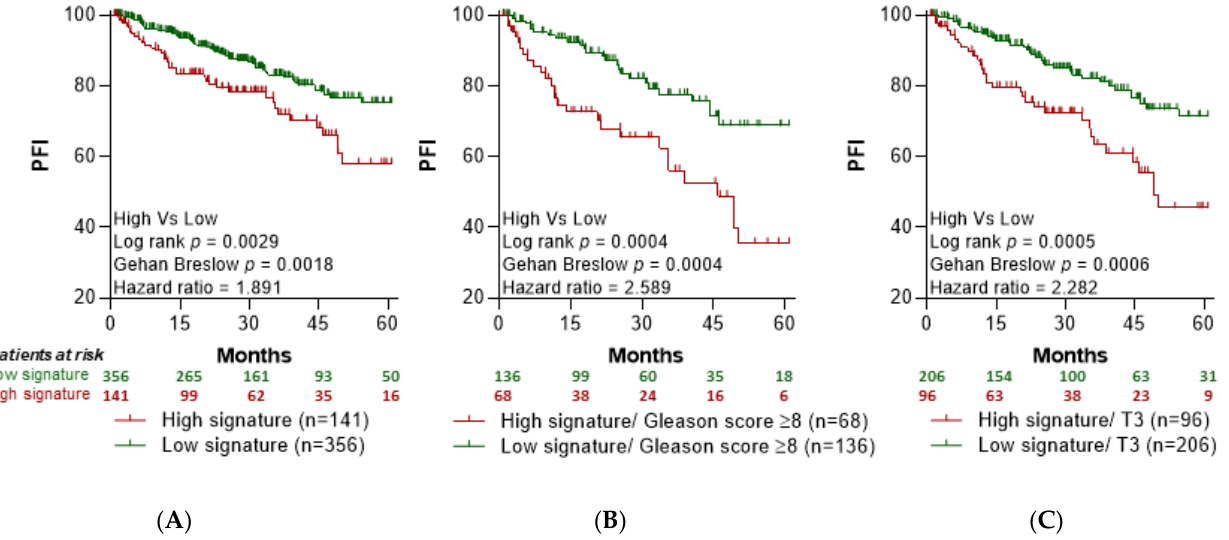
Figure 3. The 6-GS is associated with lower progression-free intervals in PCa patients. Kaplan-Meier curves for Progression Free Interval (PFI) in PCa patients were designed based on the dichotomized median expression of the 6-GS in prostate tumor tissue. ( A ) Association between the 6-GS expression levels and PFI in PCa patients. ( B ) Association between the 6-GS expression levels and PFI among PCa patients with Gleason score ≥8. ( C ) Association between the 6-GS expression levels and PFI among PCa patients with T3 (3a,3b) stage tumors. The data were extracted from the PRAD (PRostate ADenocarcinomas) dataset. The red lines indicate cases with high expression (expression value > median), while the green lines indicate cases with low expression (expression value < median) of the 6-GS. Moreover, the number of patients at risk are presented in the graph.